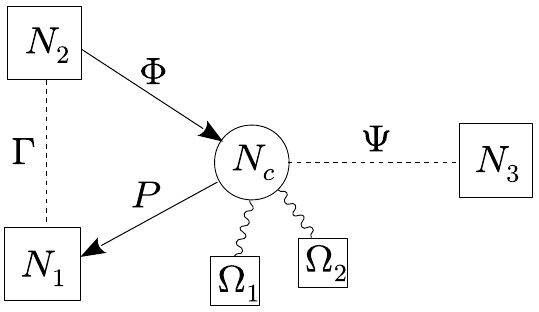
Figure 3 . The quiver diagram of N = (0 ; 2) SQCD with U( N c ) gauge group. The solid lines denote bi-fundamental chiral multiplets and dotted lines denote bi-fundamental Fermi multiplets. We have explicitly depicted the two Fermi multiplets in the determinant representation of the gauge group with wiggly